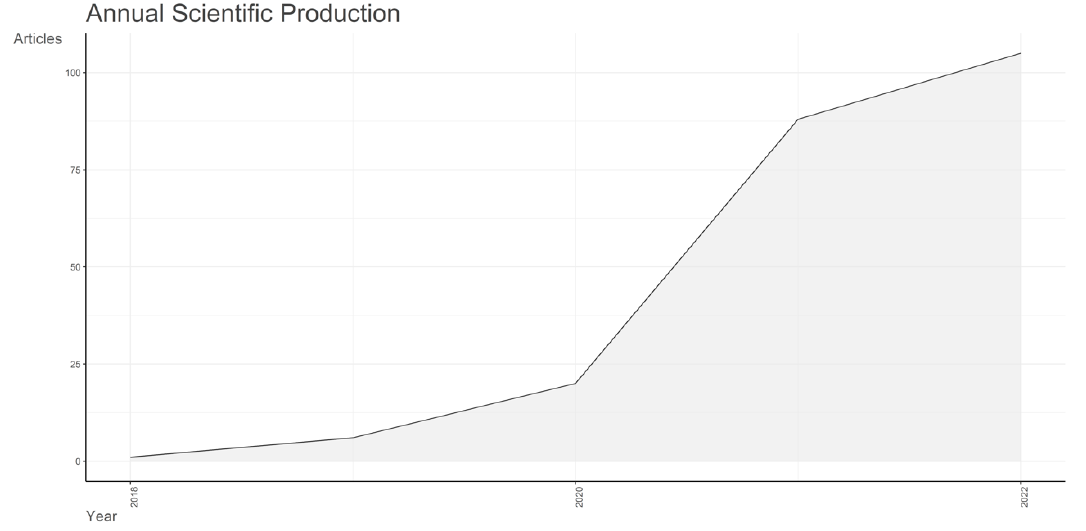
Figure 3. Annual scientific production analysis, performed with Biblioshiny version 4.0.